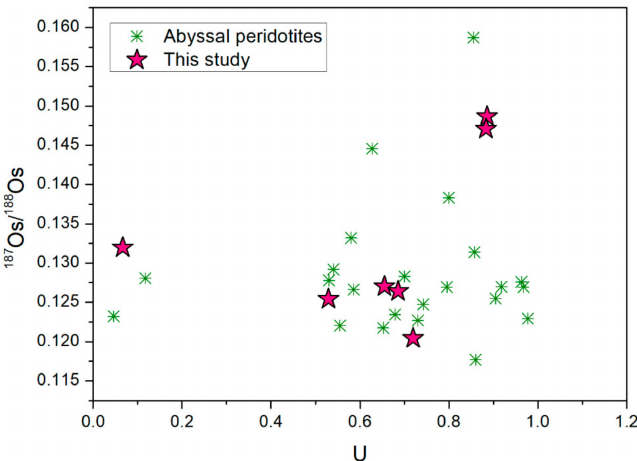
Figure 6. Plot of Re / Os versus Al 2 O 3 content of the Yap Trench peridotites. Data sources are the same as in Figure 4.